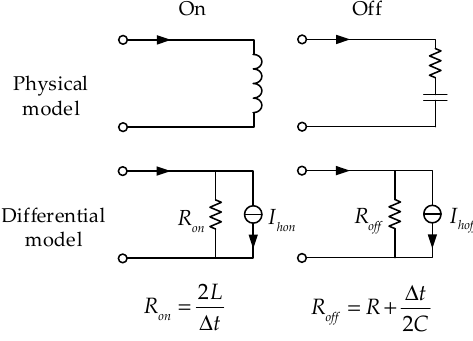
Figure 1. Differential model of L/C equivalent switch.